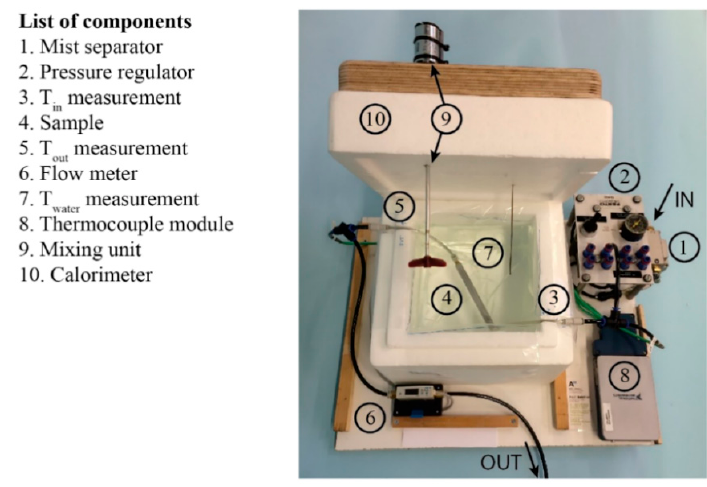
Figure 10. Test setup: Calorimeter and the components used to measure heat transfer performance of the channels. Adapted from [35].